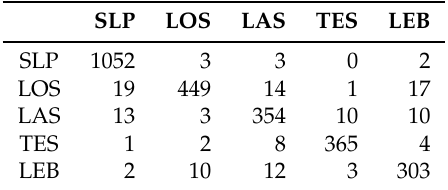
Table 5. Confusion matrixes for the results of pad sensors and rail